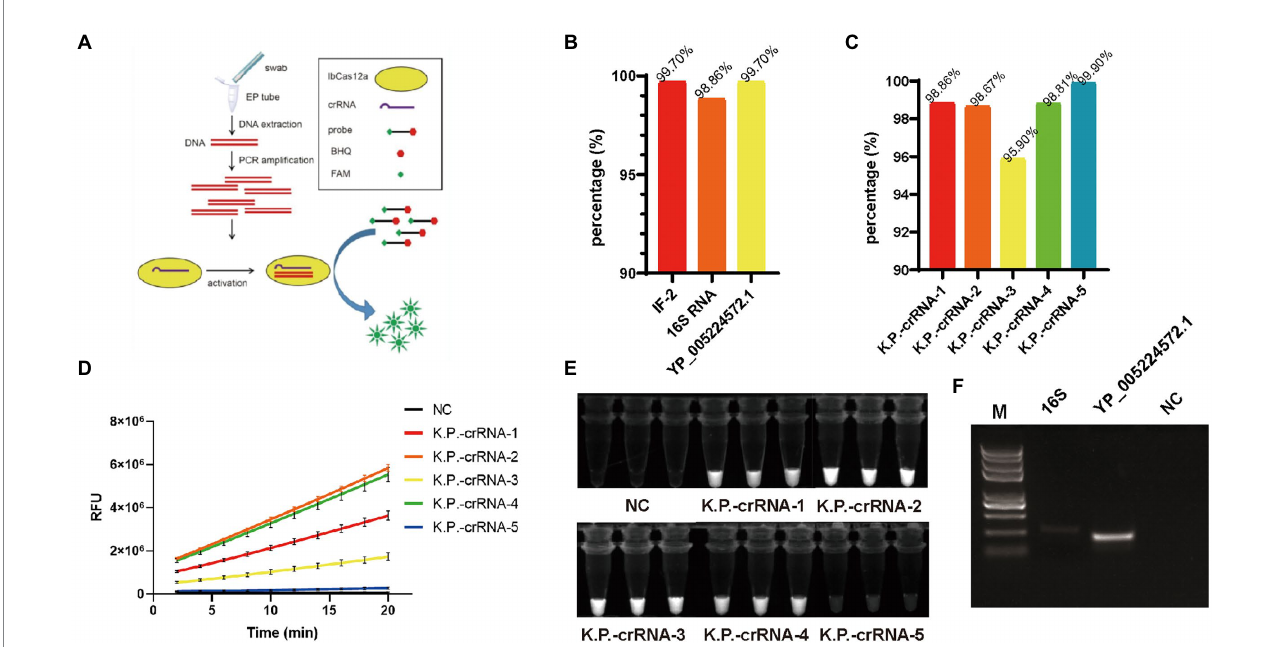
FIGURE 1 (A) Graphical illustration of PCR-LbCas12a detecting Klebsiella pneumonia nucleic acid. ( B) The proportion of IF-216SRNA and YP_005224572.1 in the 2024 K. pneumonia genomes. (C) The percentage of each K.P.-crRNA hitting the 2024 K. pneumonia genomes. (D) FAM signal of five K.P.-crRNA activity in LbCas12a reaction. (E) PCR-LbCas12a reaction products of (D) were photographed under UV activation. (F) The PCR amplification efficiency of primers targeting 16S and YP_005224572.1